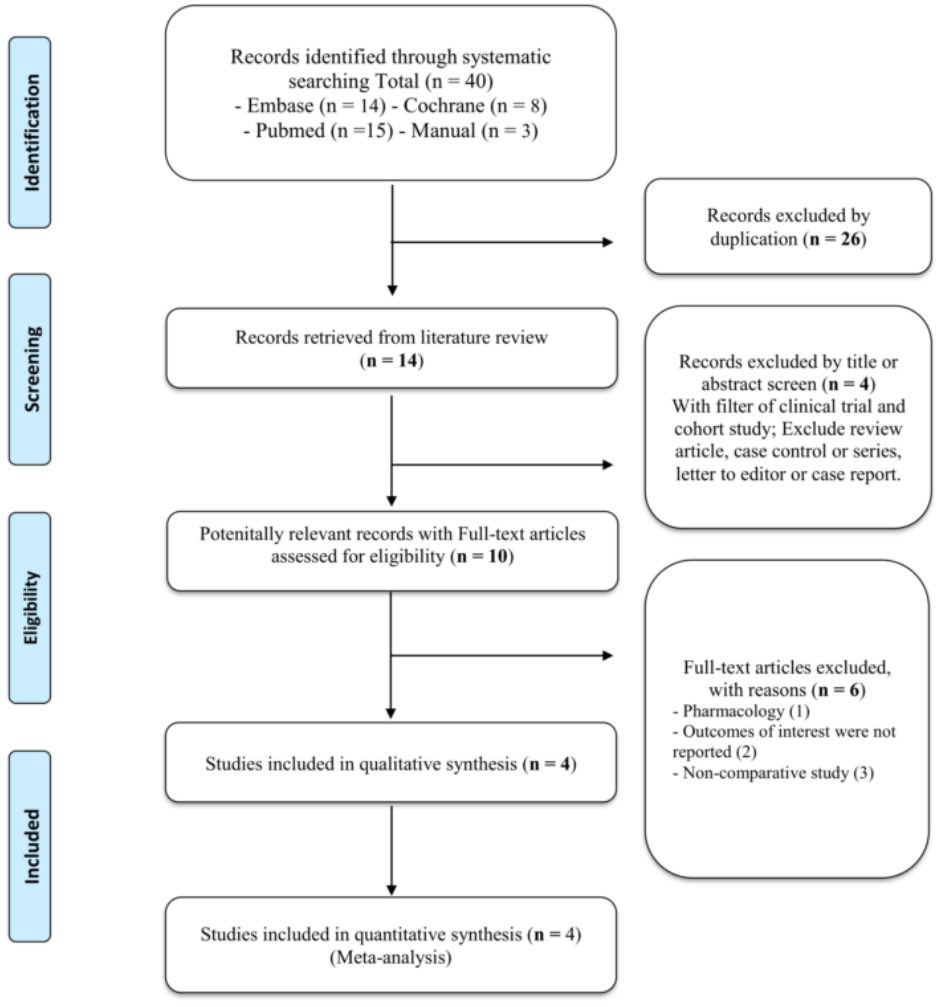
Figure 1. Flow diagram of the identification process for eligible studies.